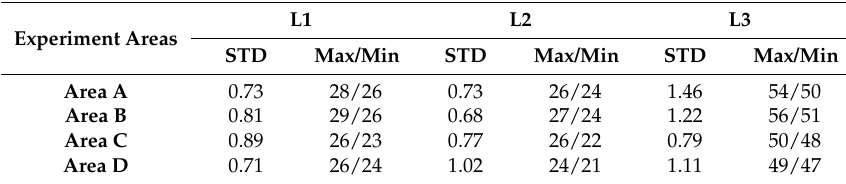
Figure 5. Comparison of the DOY lengths of time between three phenological periods (the tillering period, the heading period, and the maturation period): ( a ) L1 exhibits the time intervals between the tillering period and heading period, ( b ) L2 exhibits the time intervals between the heading period and maturation period, and ( c ) L3 exhibits the time intervals between the tillering period and maturation period, from the four experiment areas (Area A, Area B, Area C, and Area D), respectively. Table 4. The standard deviation, maximum and minimum of L1, L2 and L3 from the four experiment areas (Area A, Area B, Area C, and Area D) were counted, respectively.